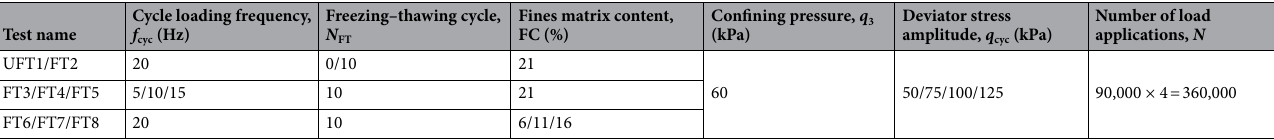
Table 2. Summary of cyclic triaxial